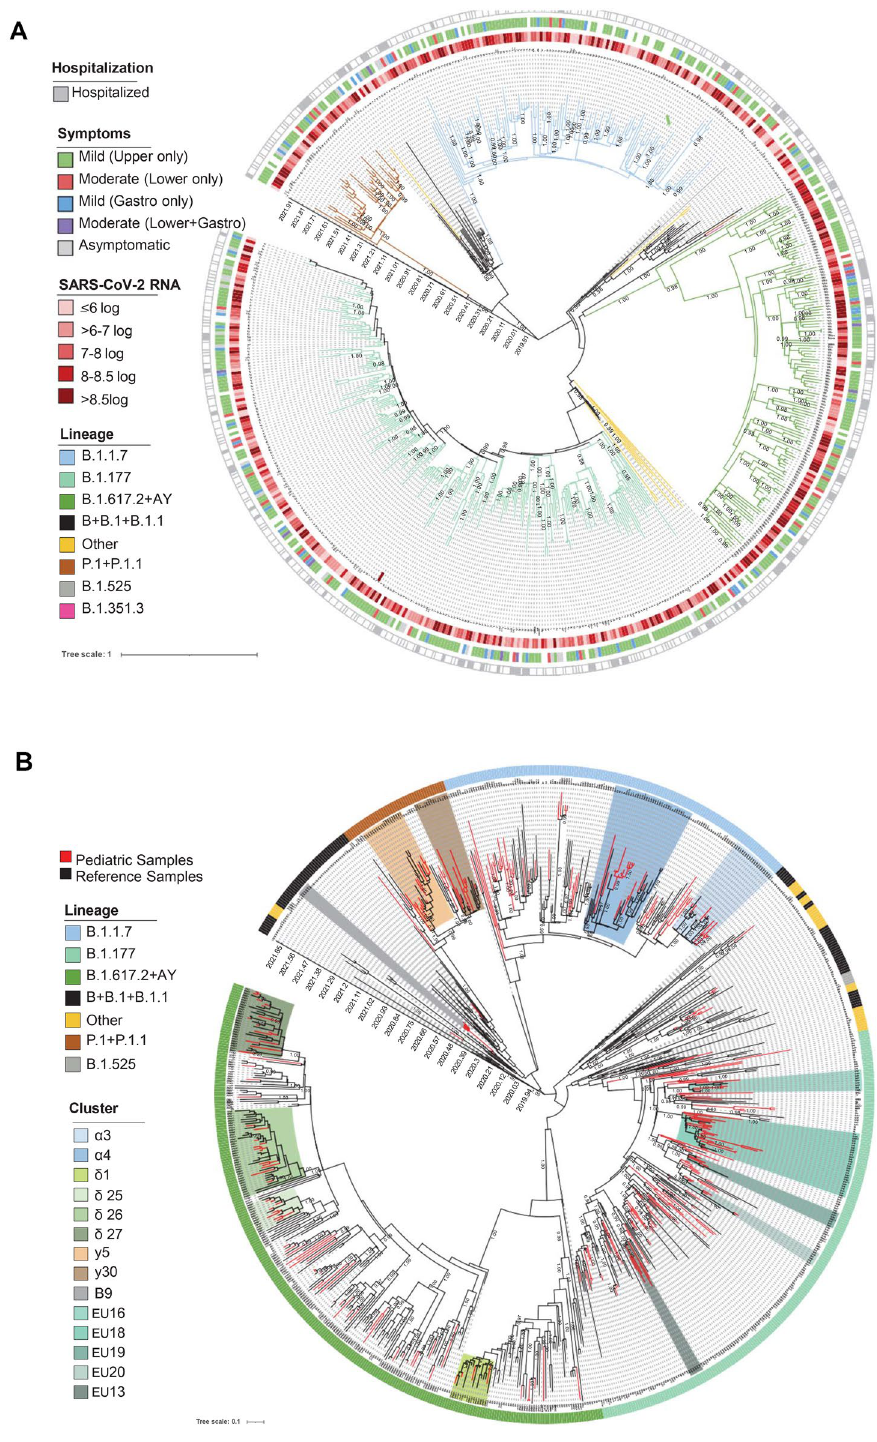
Figure 2. Bayesian phylogeographic reconstruction incorporating date of diagnosis of the 612 SARS-CoV-2 sequences obtained by population aged ≤ 12 years ( A ). SARS-CoV-2 genomes were highlighted in different colors against lineage. Information regarding Hospitalization, viral load and symptoms were also reported. Four independent chains were run for 50 million states. Parameters and trees were sampled every 1000 states. ( B ) Sampling of representative SARS-CoV-2 genomes retrieved by GISAID ( n = 294), by adolescent and adult SARS- CoV-2 infected population diagnosed in the same geographical area ( n = 207) (gray taxa), and by population aged ≤ 12 ( N = 318) were included. Two independent chains were run for 50 million states. Parameters and trees were sampled every 1,000 states. Local clusters of SARS-CoV-2 sequences supported by an intra-genetic distance < 0.0002 and a posterior probability ≥ 0.99 were highlighted in different